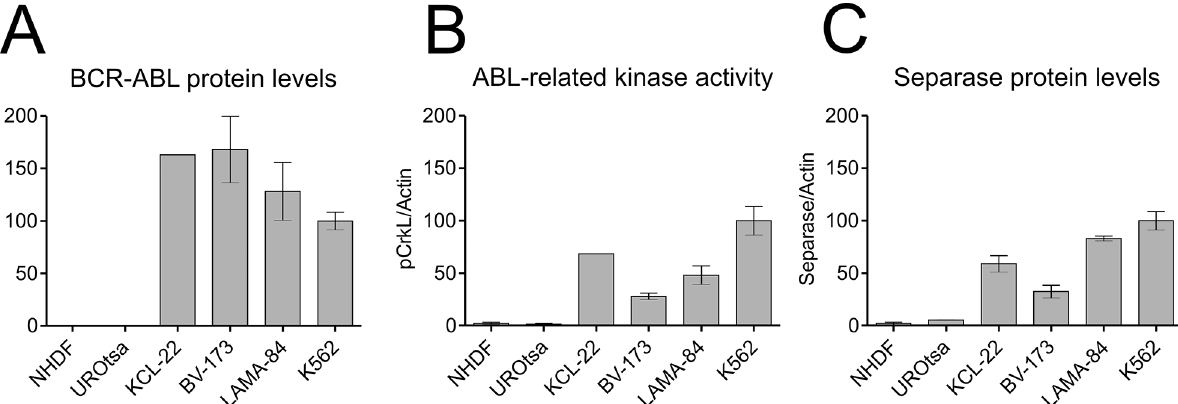
Fig 1. Protein and activity levels of p210BCR-ABL and Separase expression in cell lines under investigation. Protein levels of p210BCR-ABL ( A ), pCrkL ( B ) and Separase ( C ) based on densitometric evaluation of immunostained Western blots were normalized to Actin as loading control. Abl-related TK activity (BCR-ABL + c-ABL) was measured as pCrkL/Actin (B) . Analyses were performed on protein lysates derived from p210BCR-ABL-positive (KCL-22, BV-173, LAMA-84, K562) and-negative non-malignant cells (NHDF, UROtsa). KCL-22 and BV-173 carry the bcr-abl breakpoint variant b2a2, whereas LAMA-84 and K562 display the b3a2 fusion gene variant. All values refer to that of K562 (=